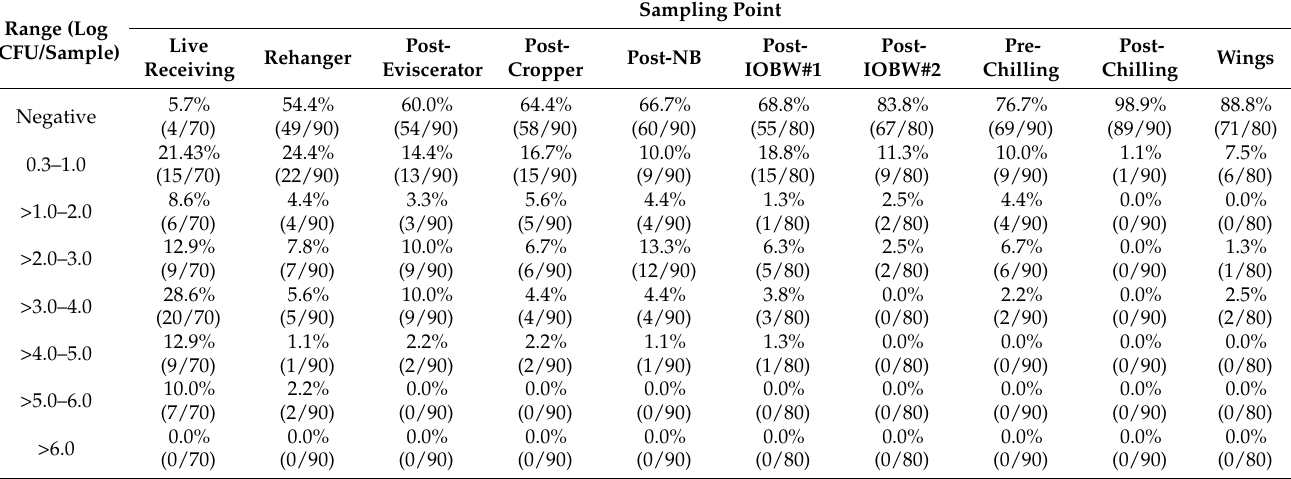
Table A6. Distribution of Salmonella counts (Log CFU/sample) on each of the ten sampling locations under reduced process intervention on chicken and part rinses (n = 850